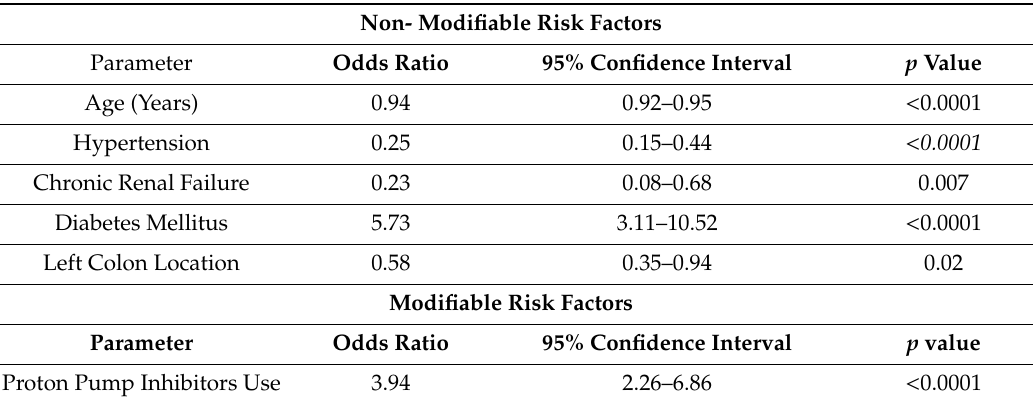
Table 3. Multivariate analysis of parameters associated with diverticulitis.